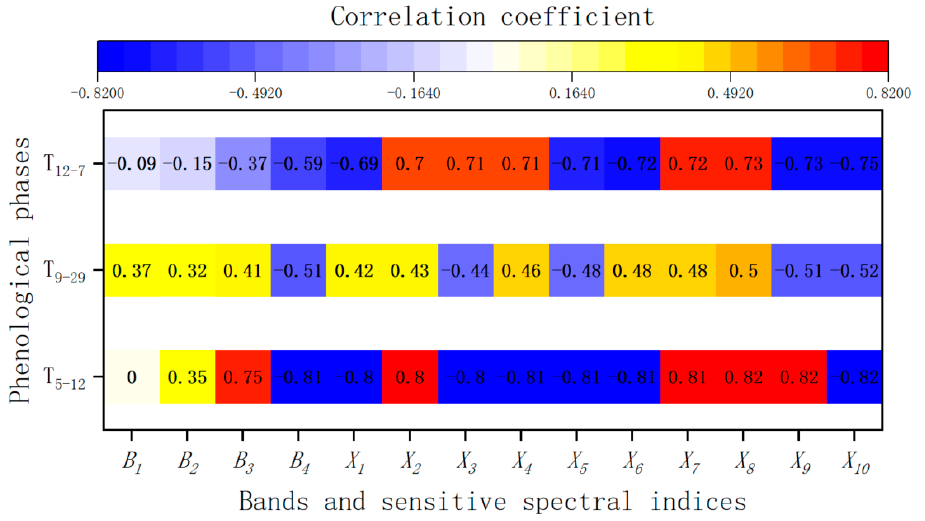
Figure 3. Correlation coefficient between band / sensitive spectral indices and tree species types.